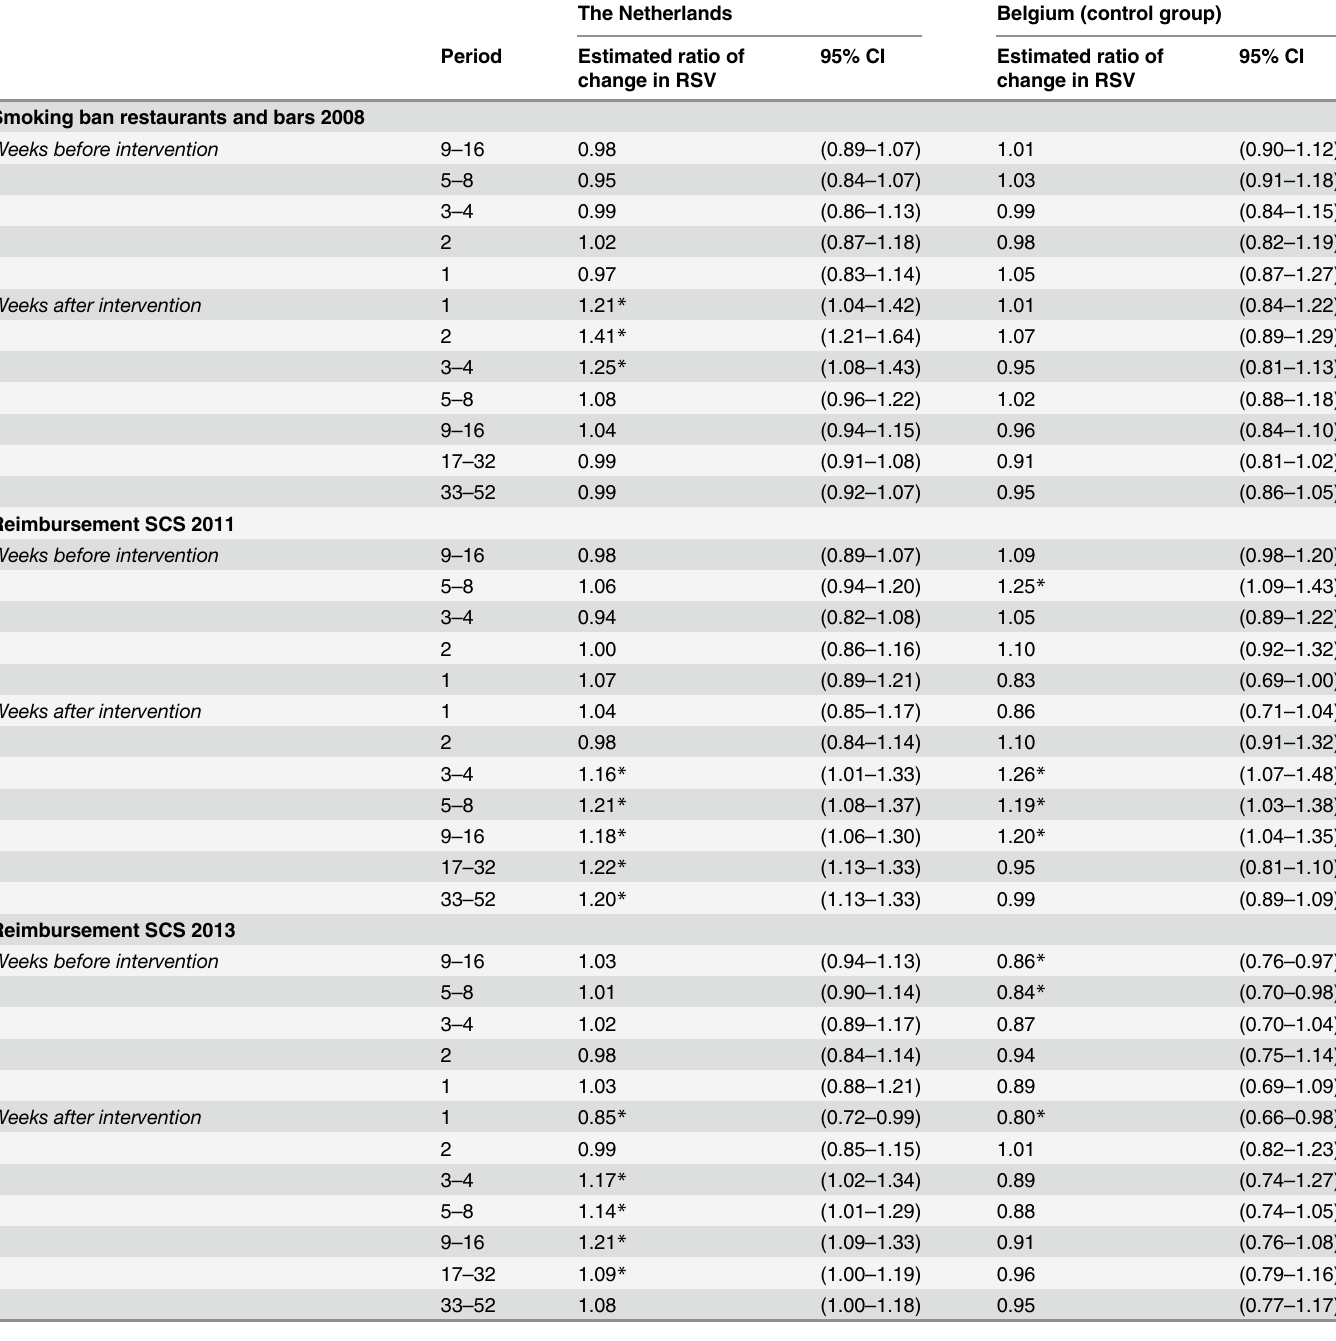
Table 3. ARIMA modelling outcomes for three Dutch smoking cessation policies of RSV data from the Netherlands and Belgium (corrected for Bel- gian interventions).